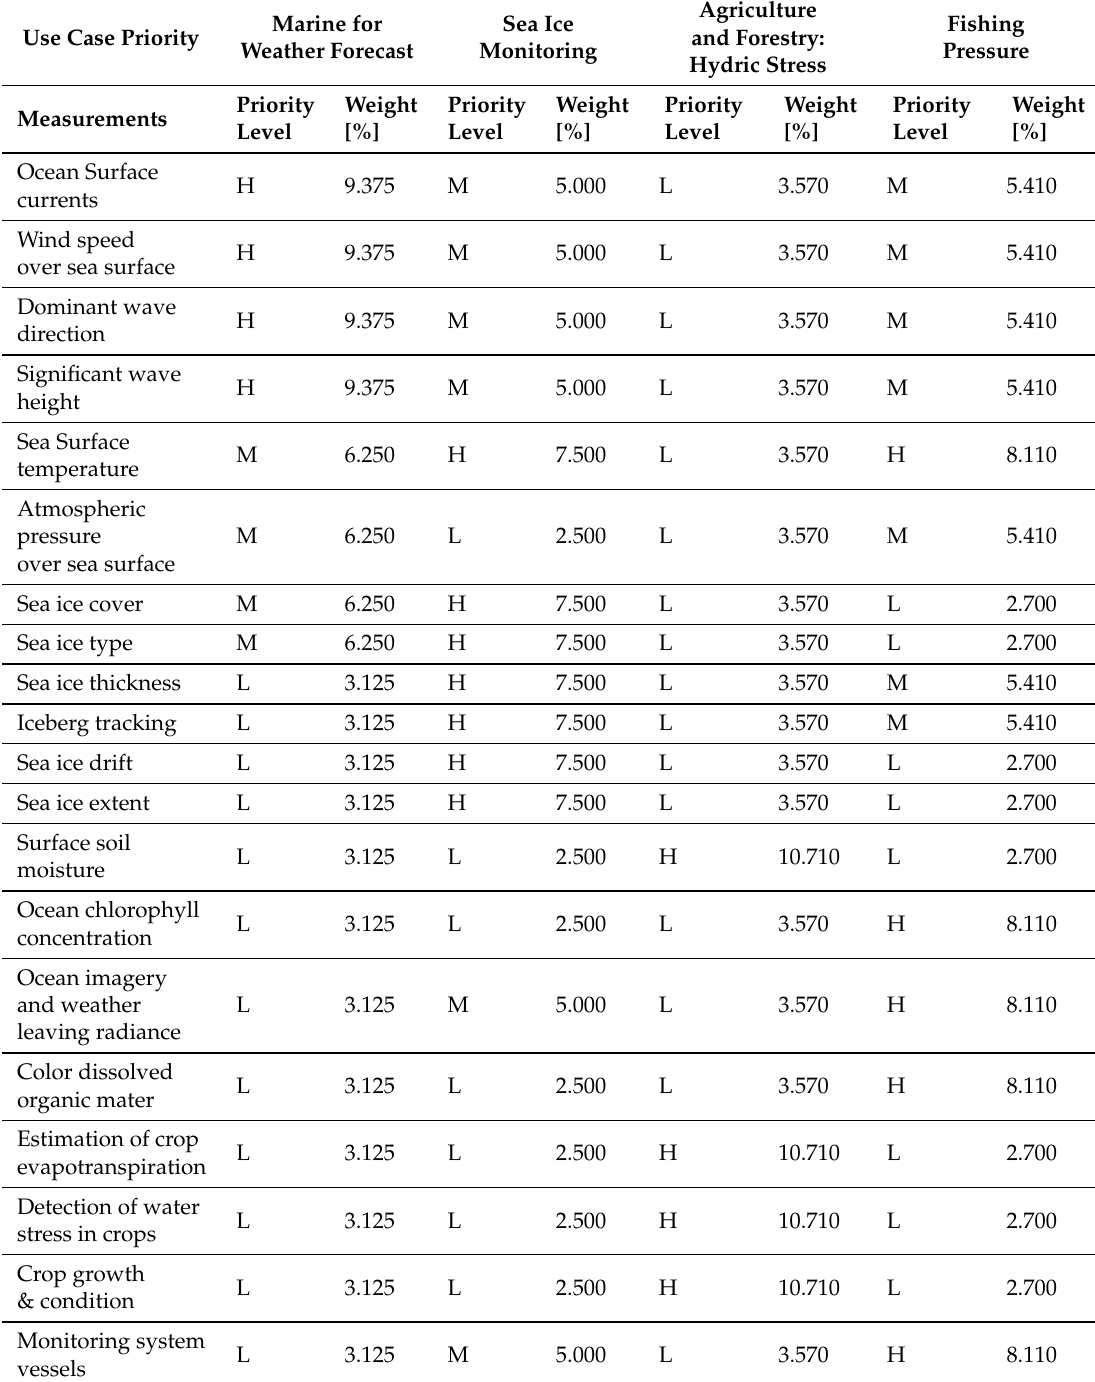
Table 11. The priority level of the measurement according to the use case